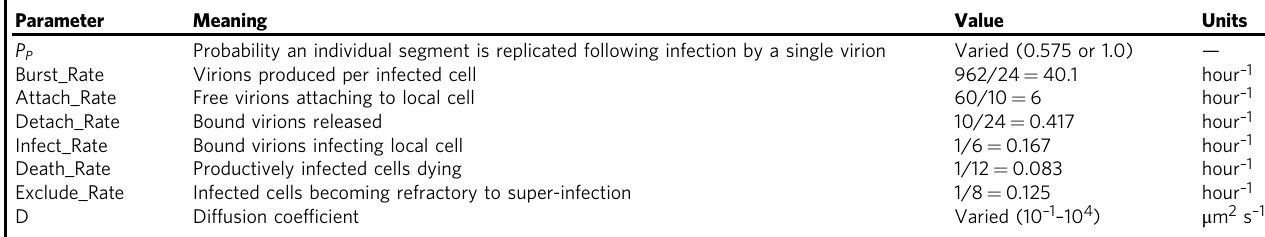
Table 1 Parameters used in model of spatially structured viral